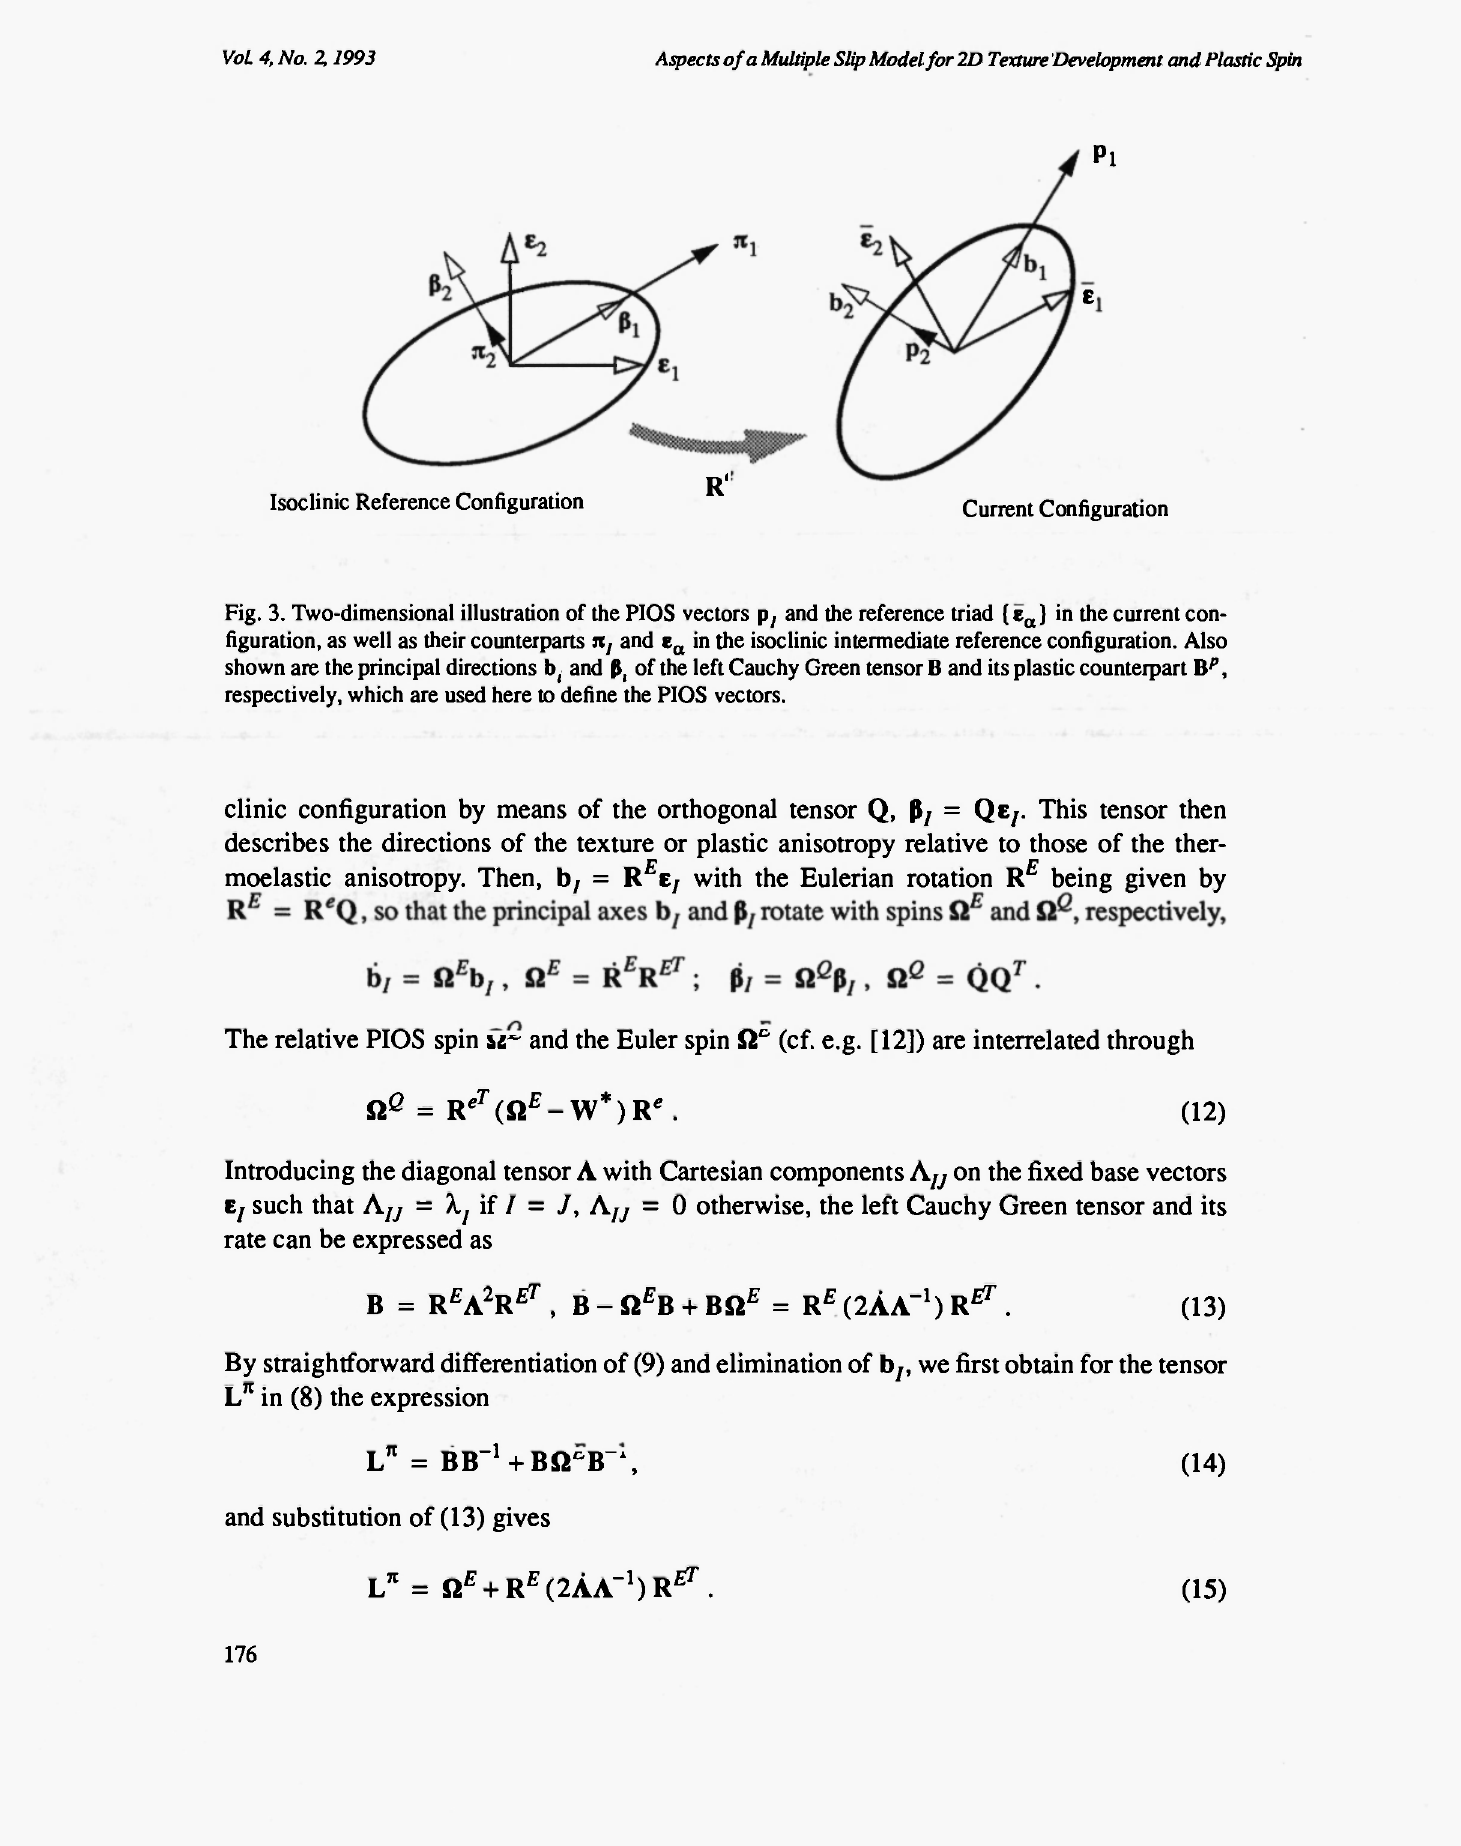
Fig. 3. Two-dimensional illustration of the PIOS vectors p, and the reference triad {ε α } in the current con- figuration, as well as their counterparts n, and ε α in the isoclinic intermediate reference configuration. Also shown are the principal directions b ( and β, of the left Cauchy Green tensor Β and its plastic counterpart B^, respectively, which are used here to define the PIOS